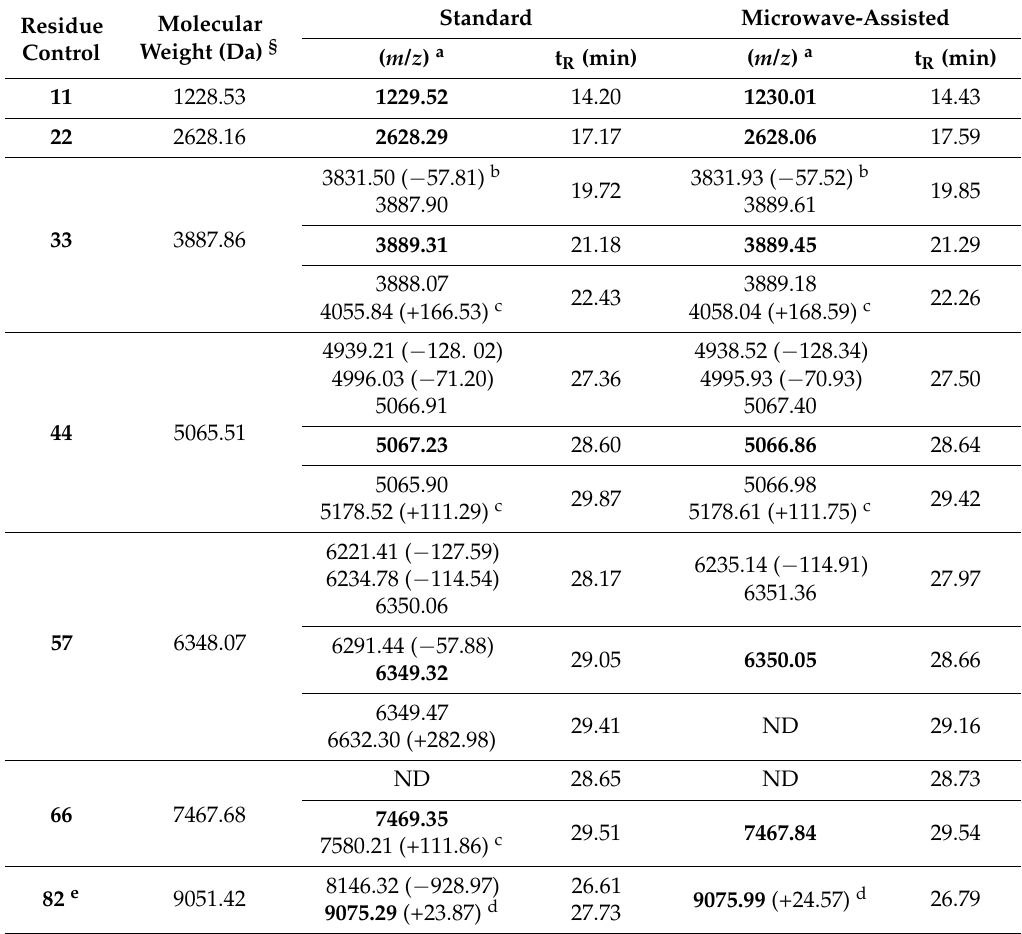
Table 1. Results of controls and chimeric peptide for standard and microwave (MW)-assisted